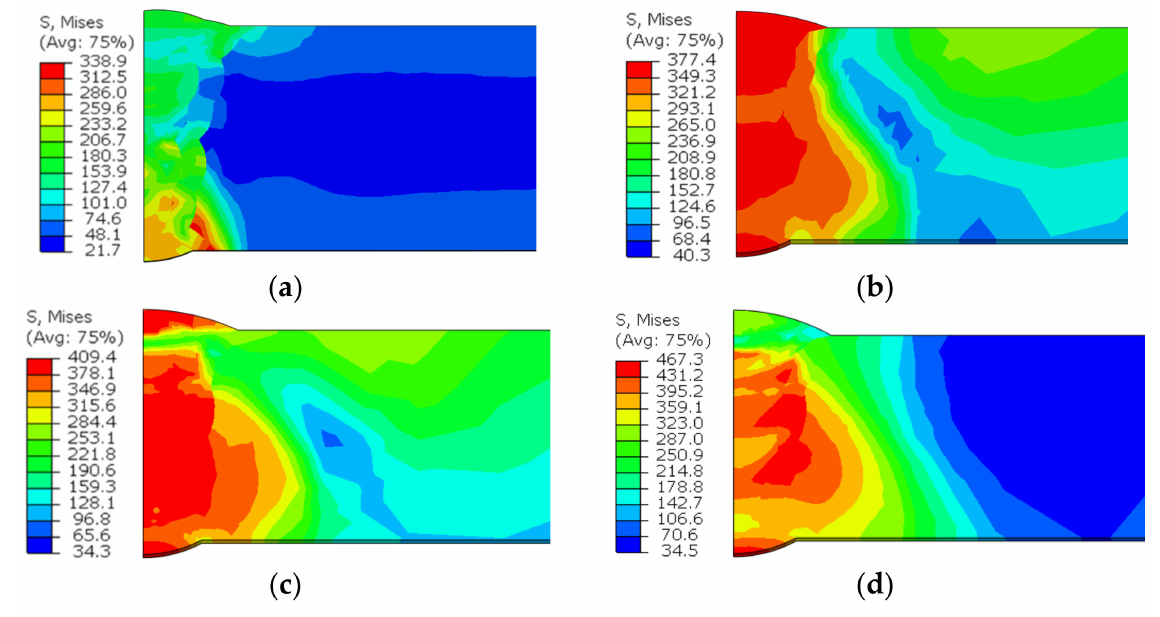
Figure 14. Equivalent stress field nephogram with butt gaps of: ( a ) 0 mm, ( b ) 1 mm, ( c ) 2 mm, ( d ) 3